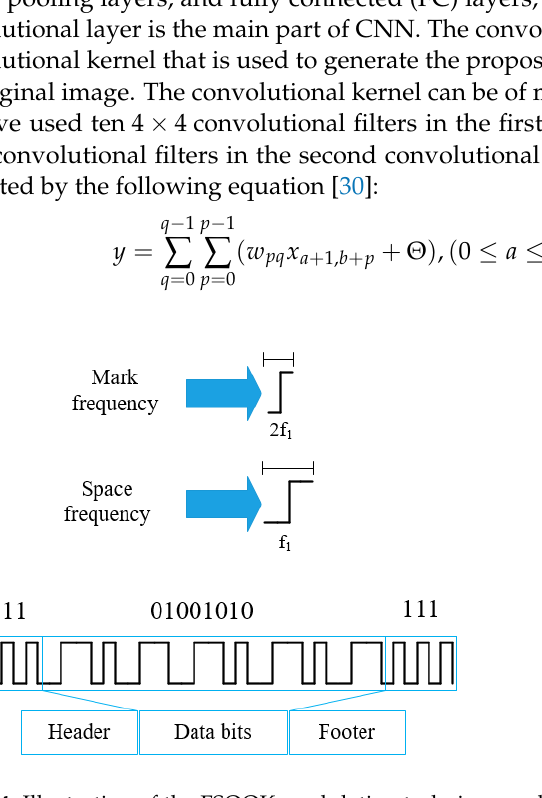
Figure 4. Illustration of the FSOOK modulation technique and data packet architecture.